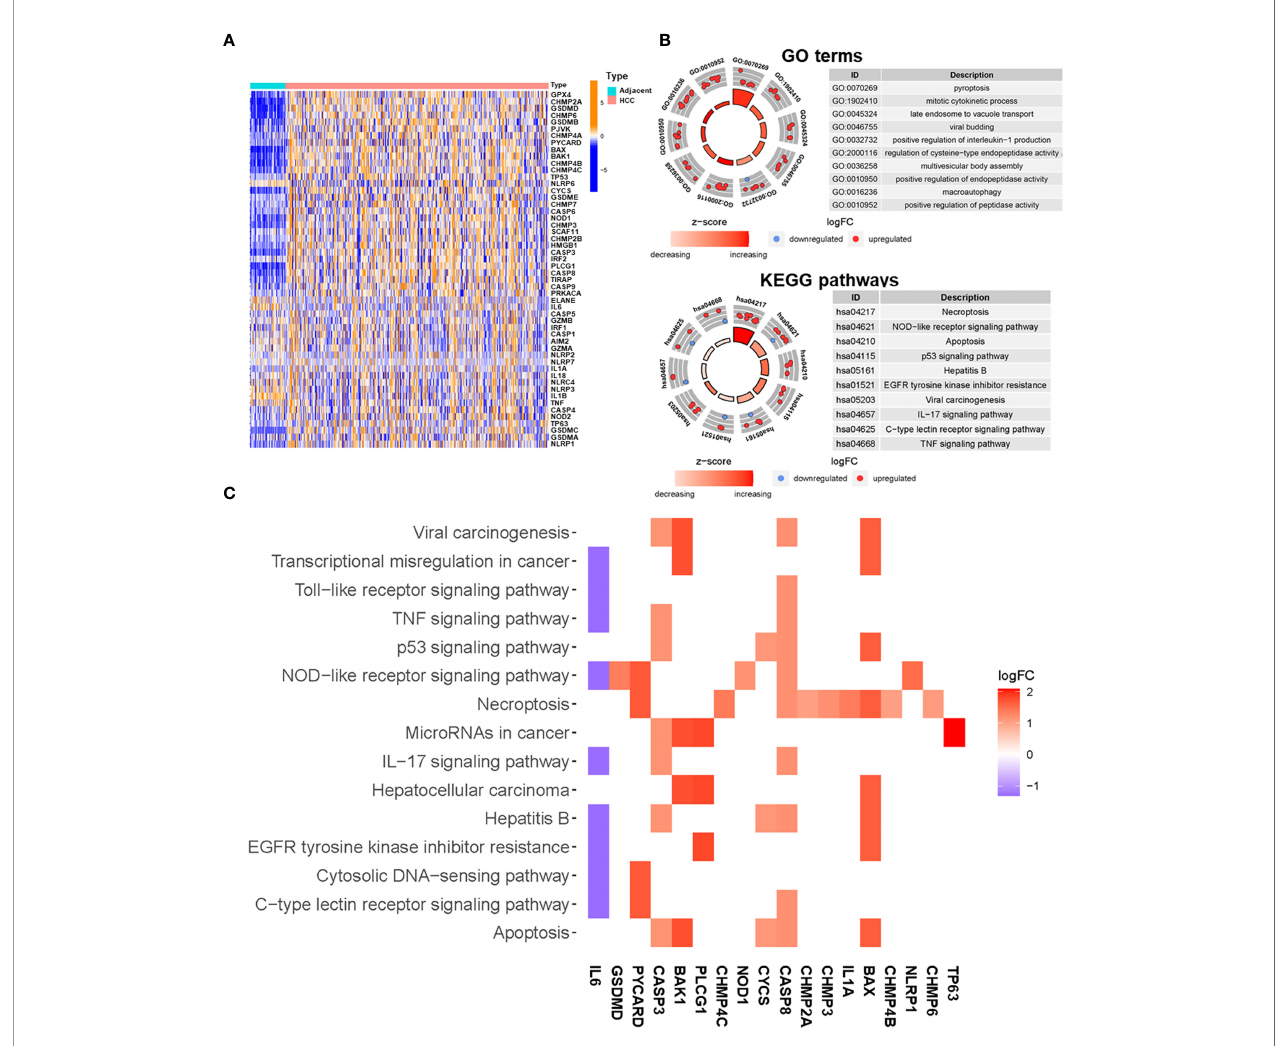
FIGURE 2 | Functional enrichment analysis of differentially expressed pyroptosis-related genes. (A) Heatmap of expression of pyroptosis-related genes in HCC and adjacent tissues (blue: low expression level; dark orange: high expression level). (B) Enriched GO terms (up) and KEGG pathways (down) for differentially expressed pyroptosis-related genes. The outer circle shows a scatter diagram of the log fold change (FC) value allocated to each term. (C) Heatmap showing the relationships between differentially expressed pyroptosis-related genes and enriched KEGG pathways. Colors represent the logFC values of each gene in HCC compared with adjacent